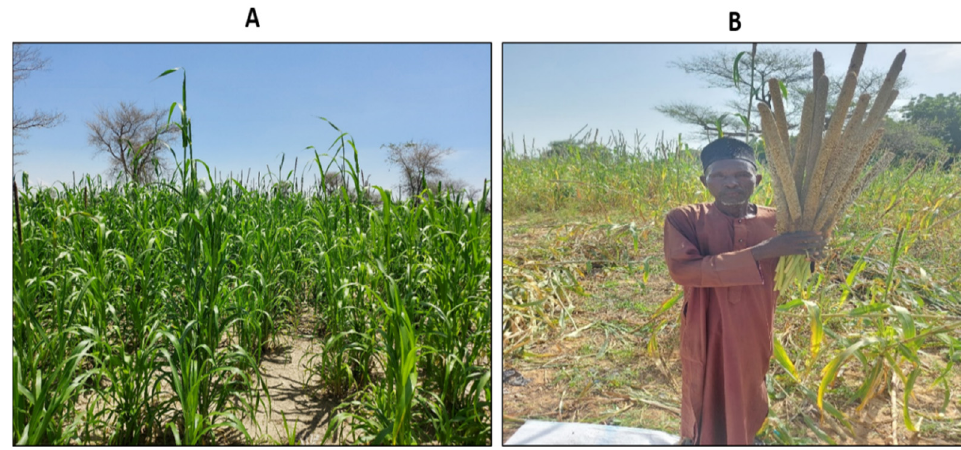
Figure 2. Nursery ( A ) and transplanting operations ( B ) at the village of Dan Kirey.